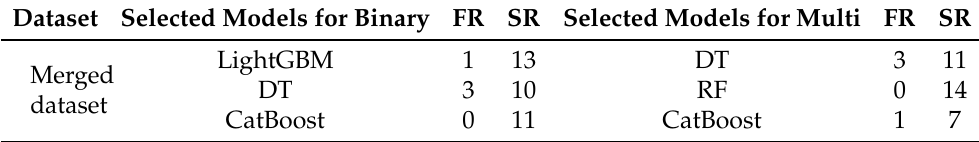
Table 9. Final selected models for binary and multi-classification.